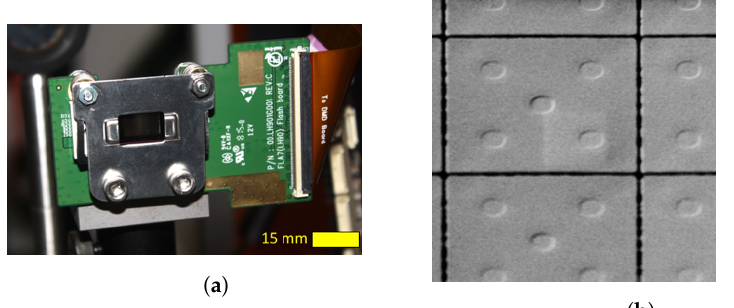
Figure 4. ( a ) Phase-only spatial light modulator (PLM) in housing and ( b ) scanning electron micro- scope (SEM) image of individual mirrors (courtesy of Texas